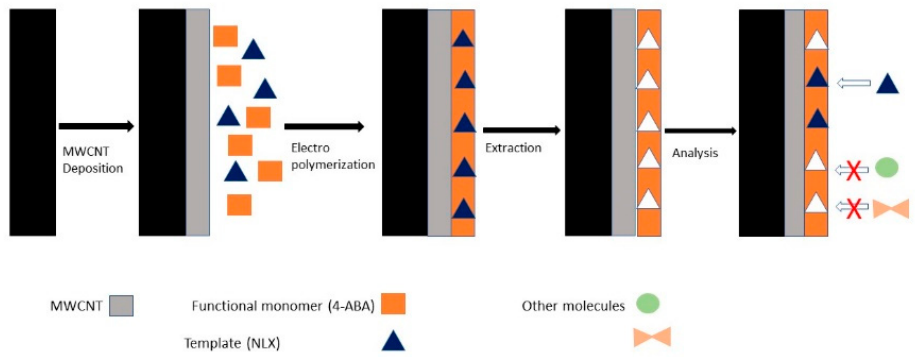
Figure 3. Schematic illustration of the preparation of the molecularly imprinted polymer (MIP)/multi